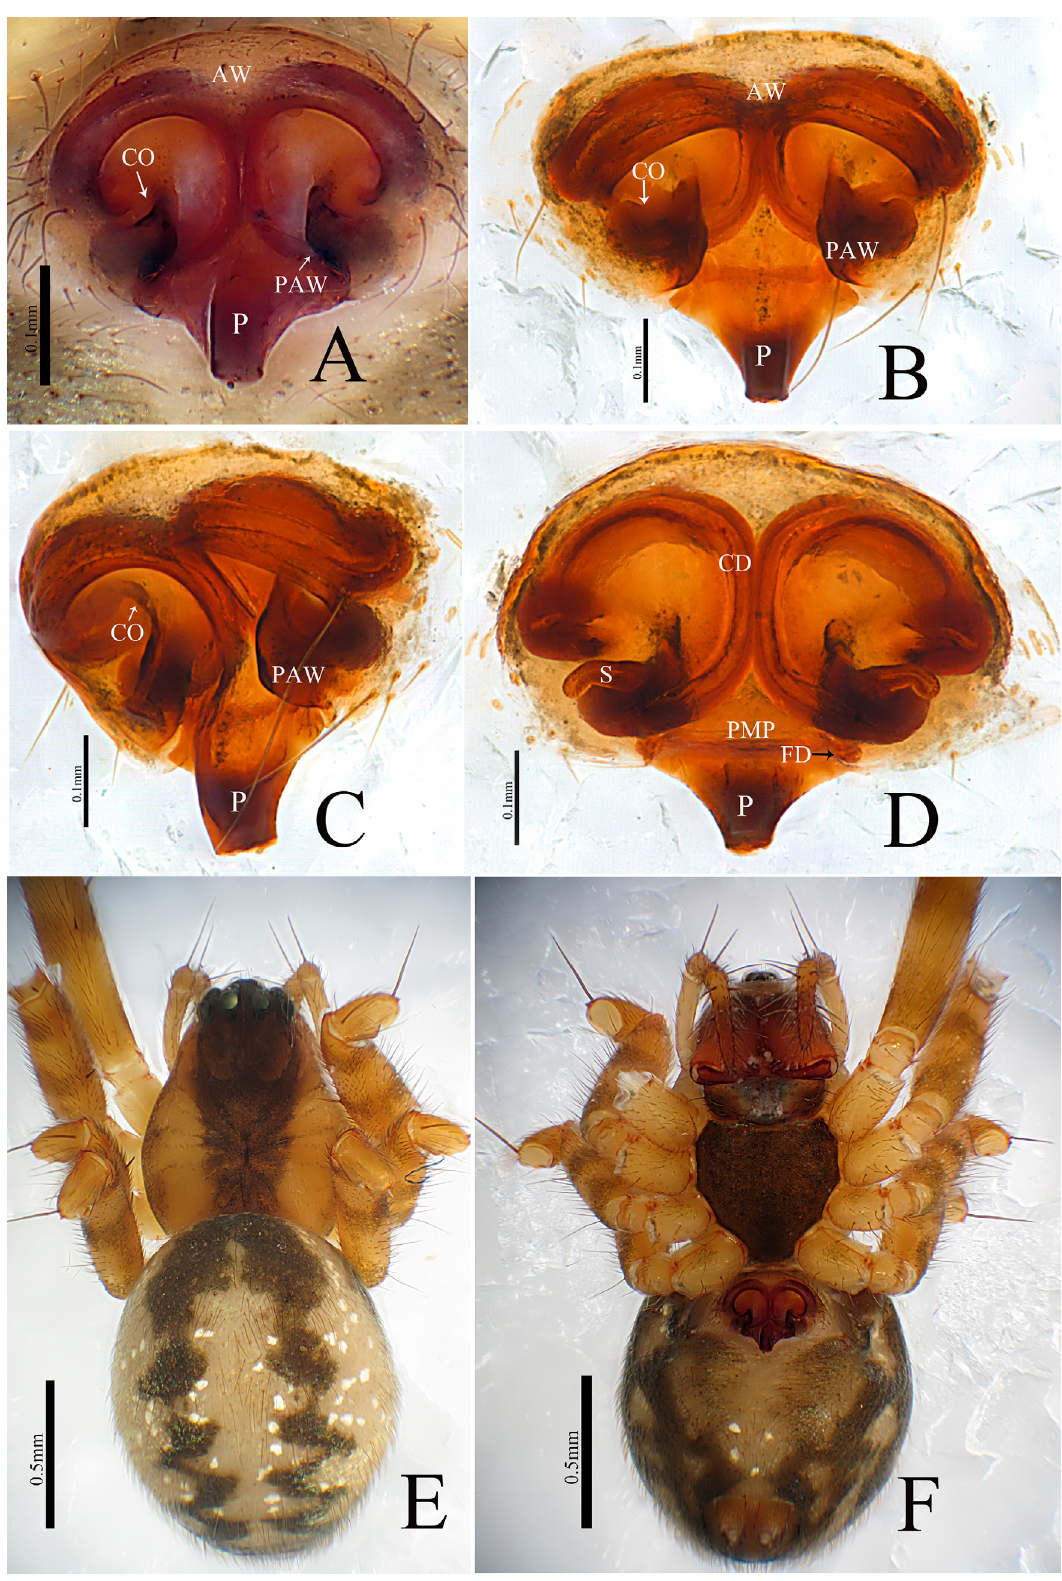
Fig. 21. Acroterius hamatus gen. et sp. nov., ♀, paratype (HNU-Tang–04–09). A–B . Epigyne, ventral view. C . Epigyne, lateral view. D . Vulva, dorsal view. E . Habitus, dorsal view. F . Habitus